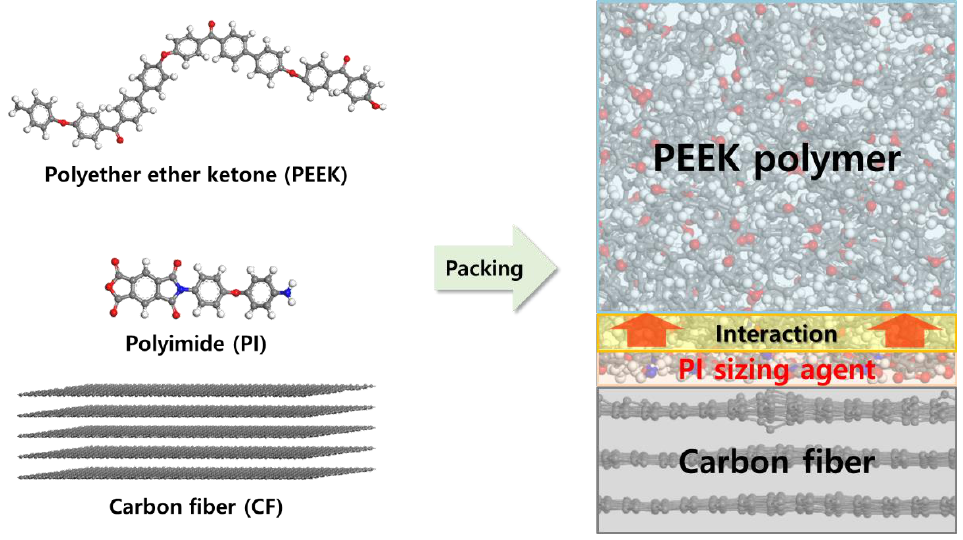
Figure 3. Molecular structures and composite models in the MD simulations.